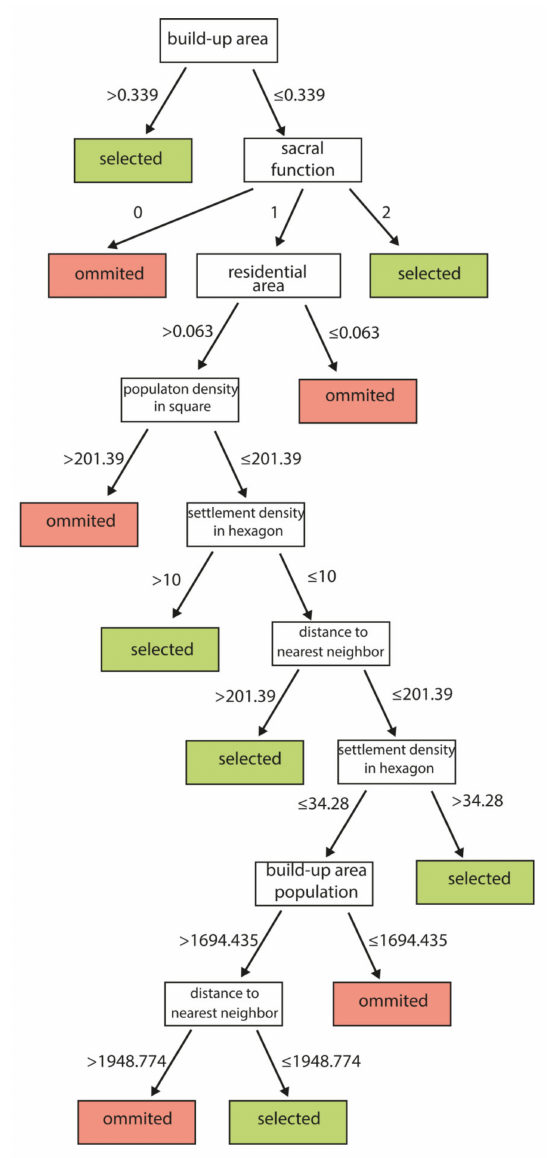
Figure 10. Decision tree for group 4, result of machine learning using the DT-GA